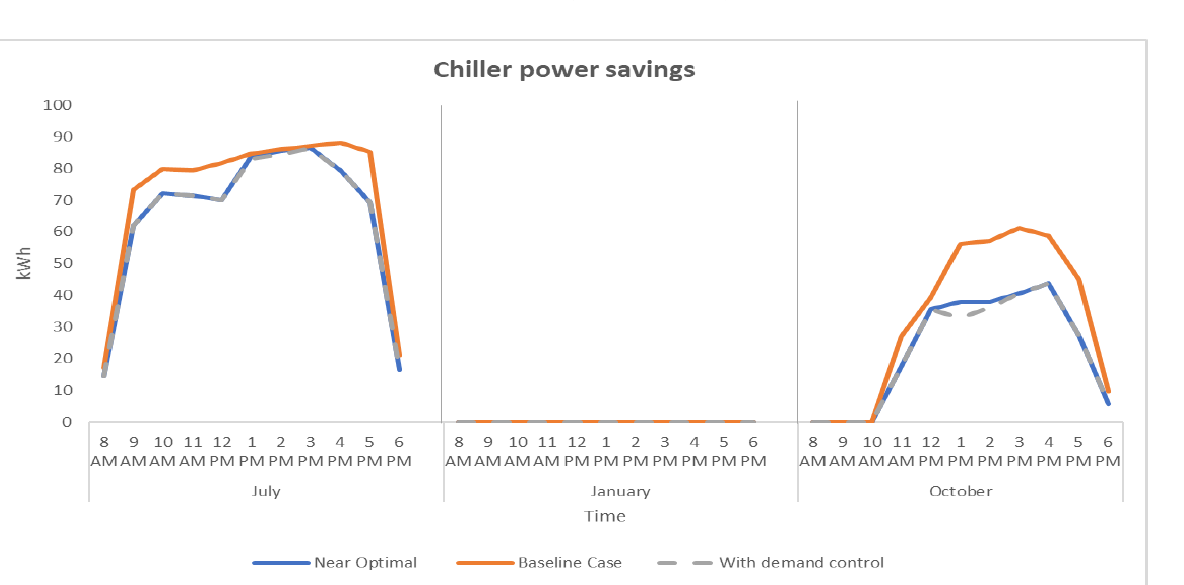
Figure 14. The chiller power savings for each day being analyzed.